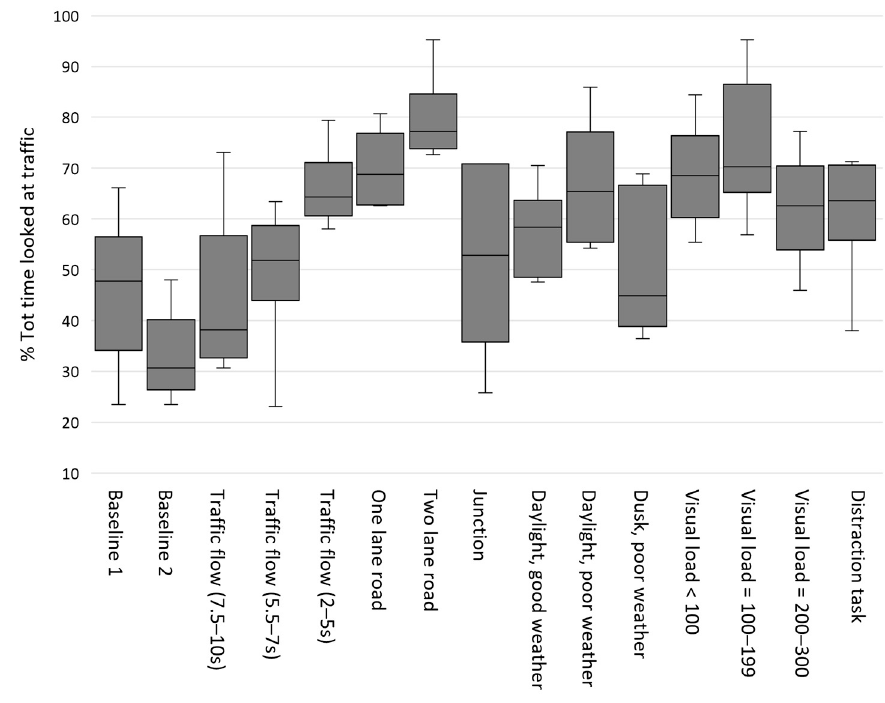
Figure 9. Median percentage of total time gazing at traffic by